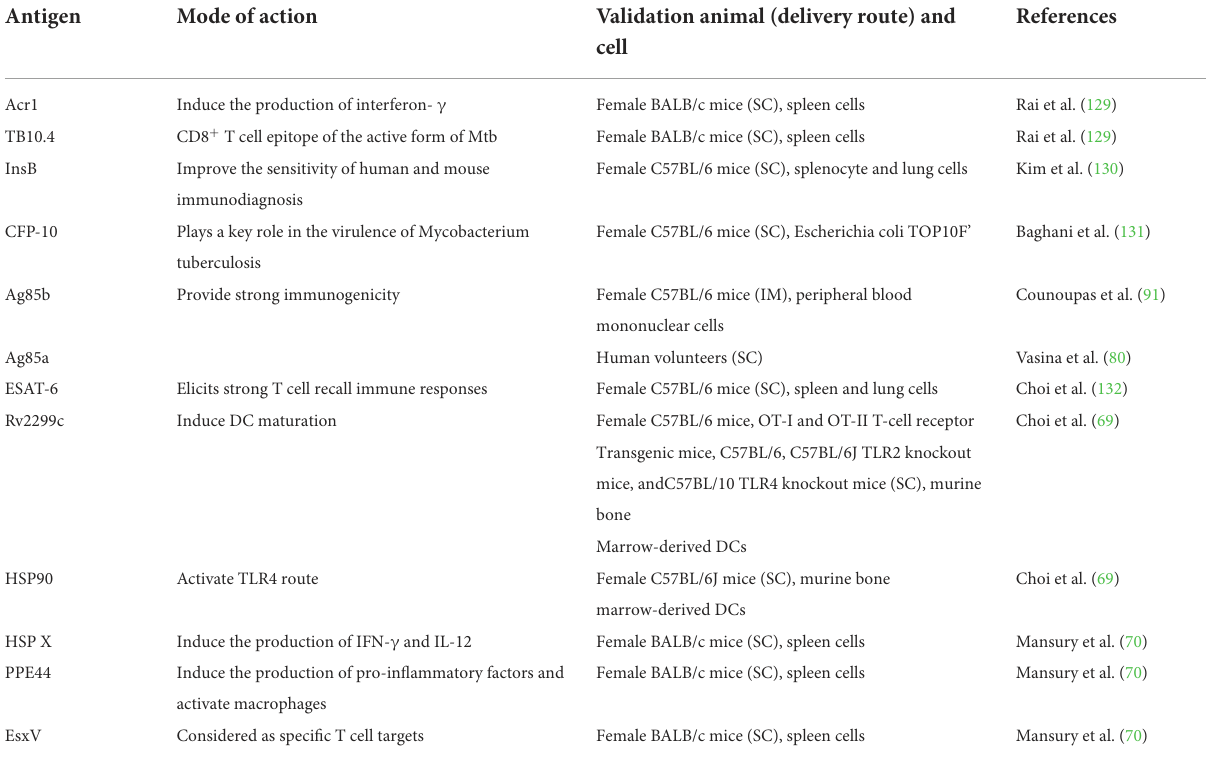
TABLE 2 Summary of tuberculosis